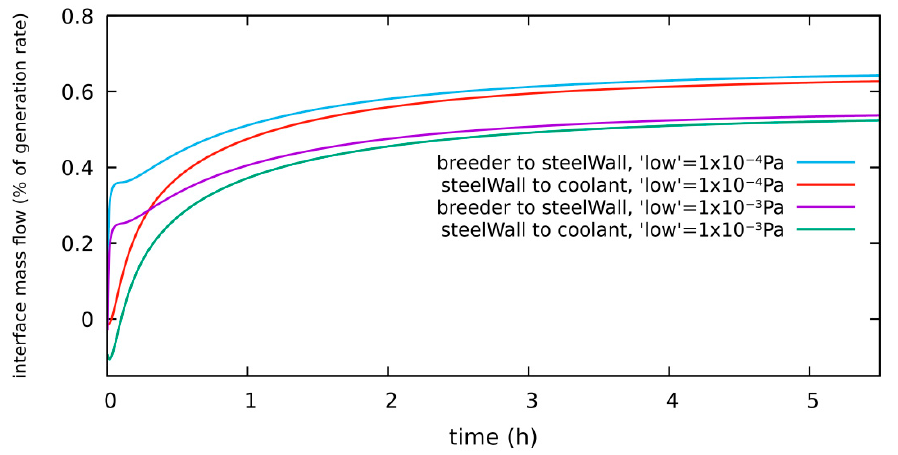
Figure 11. Transient tritium flow through patch interfaces breeder to and from steel, and steel to and from coolant for 1 × 10 − 4 Pa vs. 1 × 10 − 3 taken as low level in inlet BCs. 4.1.5. HT System, Diffusion-Limited, 300 Pa H 2 in Purge Gas, New “Low” Level: 1 × 10 − 4 Pa, K r_HT × 2